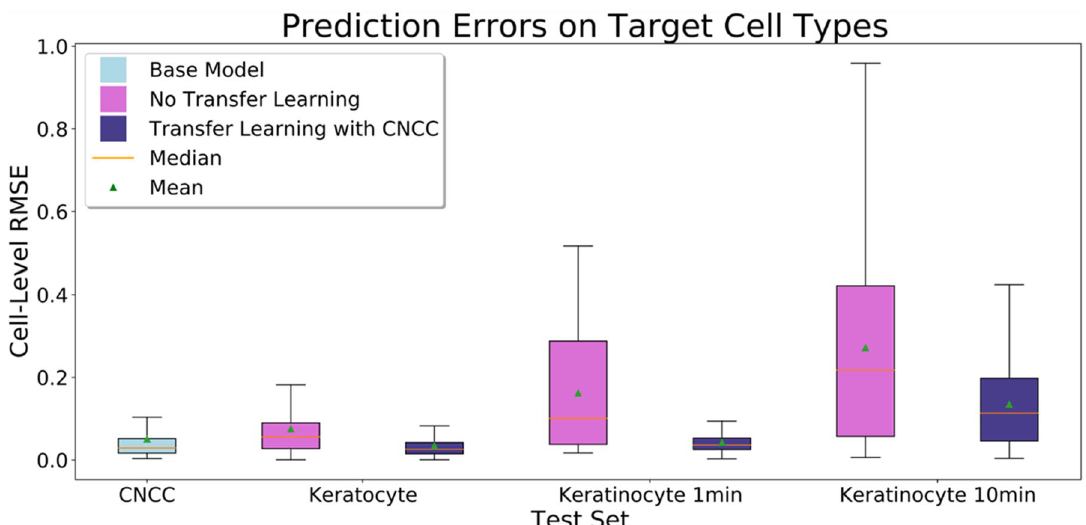
Figure 6. Distributions of RMSE values for the base model on the CNCC test set (benchmark), the keratocyte model on the keratocyte test set, and the transfer learning model on the keratocyte test set. Distributions of RMSE values for the base model on the CNCC test set (benchmark), the target cell models without transfer learning on the target cell test sets, and the target cell models which used transfer learning with the CNCC source domain on the target cell test sets. The boxes represent the middle 50% of error values and the whiskers extend to the minimum and maximum error